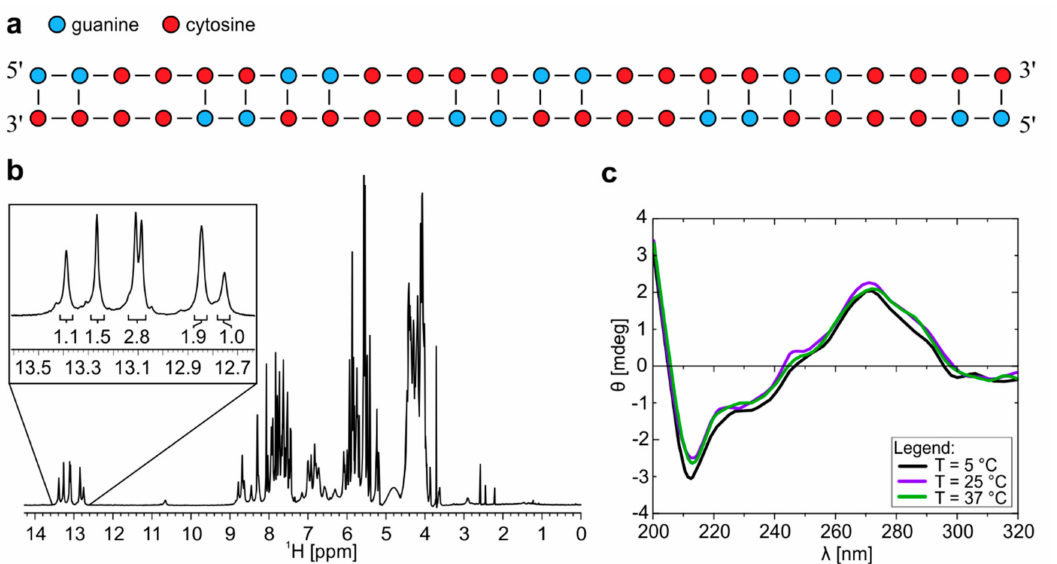
Figure 1. 1 H-NMR and CD spectra of r(G 2 C 4 ) 4 at pH 7.0 forms dimeric structure. ( a ) Schematic presentation of homodimer with G-C base pairs and C-C mismatches. ( b ) 1 H-NMR spectrum of r(G 2 C 4 ) 4 in 10% 2 H 2 O at pH 7.0, 25 ◦ C and 0.9 mM oligonucleotide concentration per strand. Numbers below the signals represent integral values. c ) CD spectra of homodimer with concentration of 100 µ M per strand at 5, 25 and 37 ◦